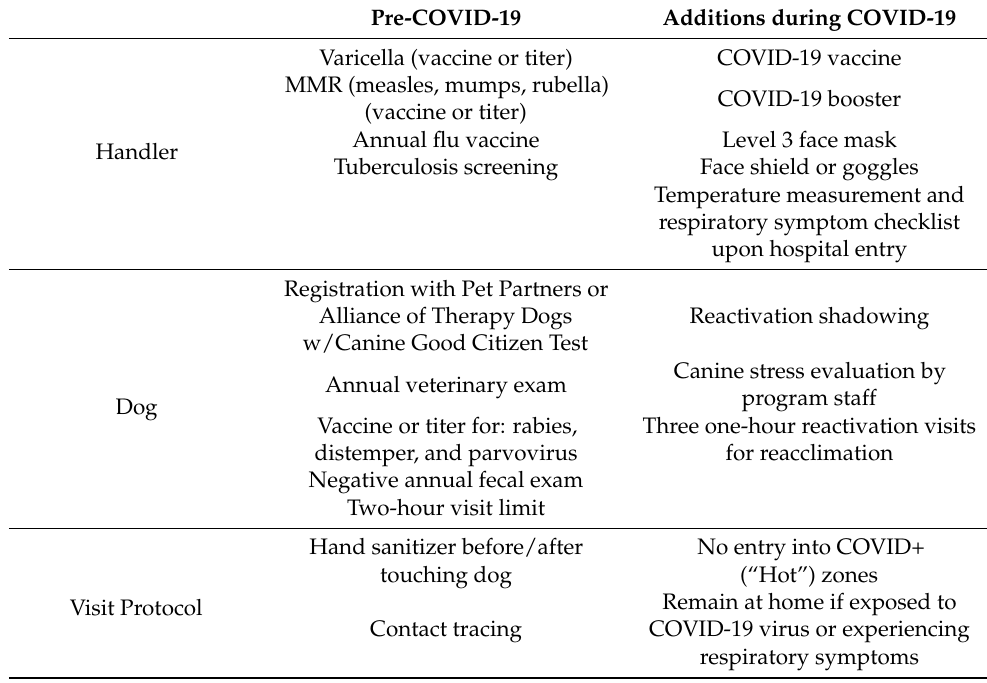
Table 1. Handler and dog health and safety